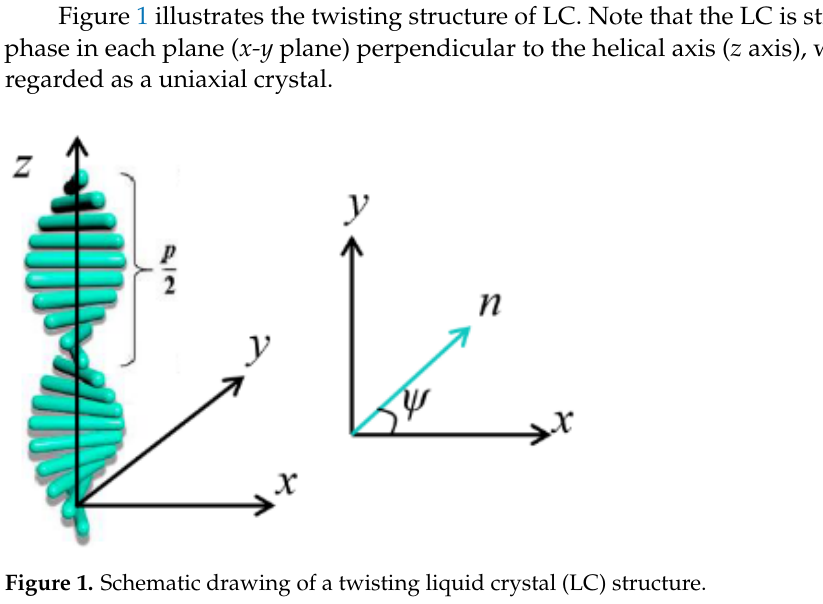
where ψ is the azimuth angle at z , ϕ 0 is the azimuth angle of the initial position ( z = 0). The helical pitch P was defined as the distance in which the orientation of LC molecules rotated 360 degrees. The direction of the twist is represented by the sign of the helical pitch P , usually the right-handed twisting is defined as positive ( P > 0). According to the relationship between the wavelength and the helical pitch, the optical property of the LC layer could be divided into four different regions [31]: 1. Mauguin region: In this region ( λ << 0.5 ∆ nP ), the polarization ellipses of the eigen- modes have either near-infinite ellipticity with the long axis parallel or perpendicular to the local director, which could be approximated as a pair of orthogonal linear